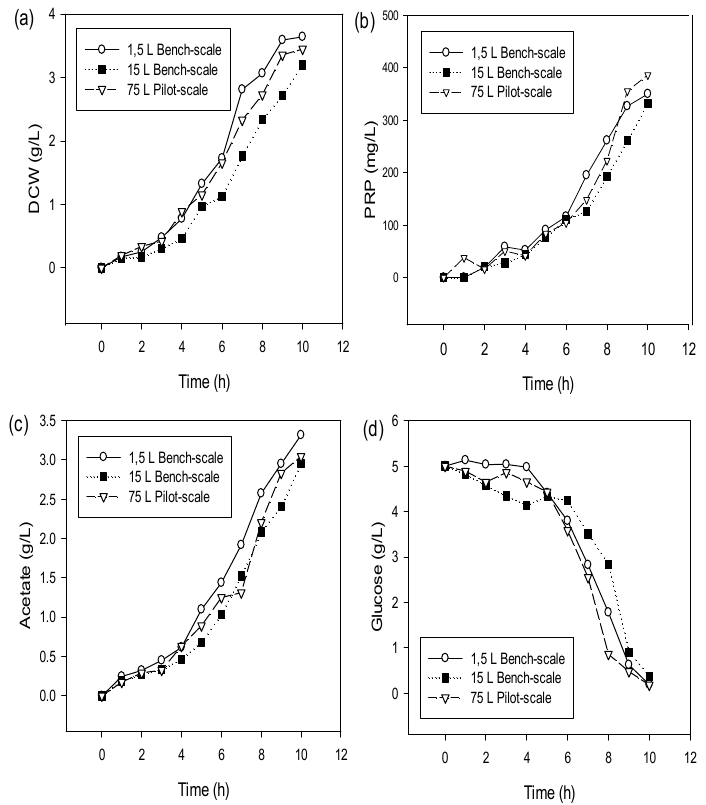
Figure 2. Time-course profiles of parameters’ culture of H. influenzae at k L a values equal 52 h −1 in three size bioreactor systems: 1.5 L −1 bench–scale, WV: 0.8 L −1 , OC: 500 rpm and 0.25 vvm; 15 L